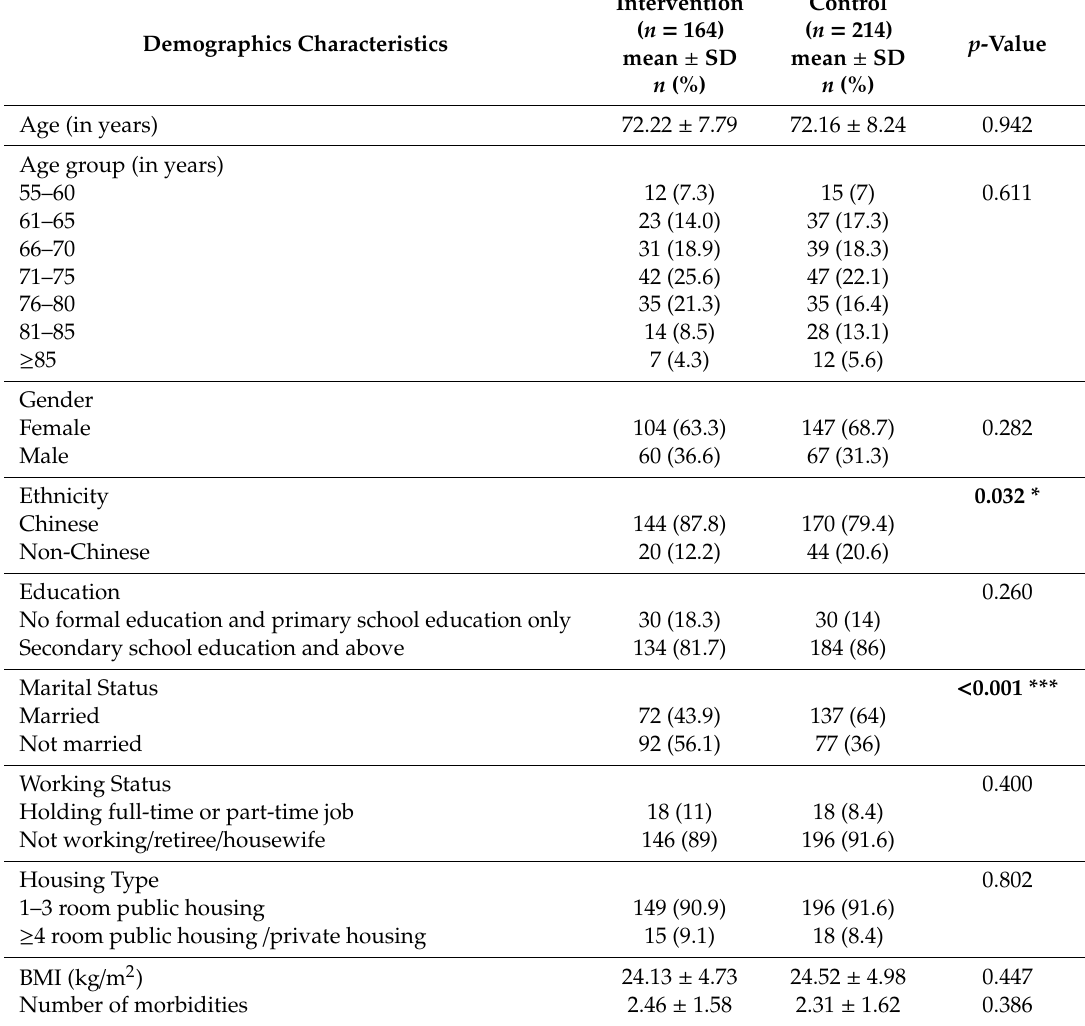
Table 1. Demographic characteristics of participants in the intervention and control arms at